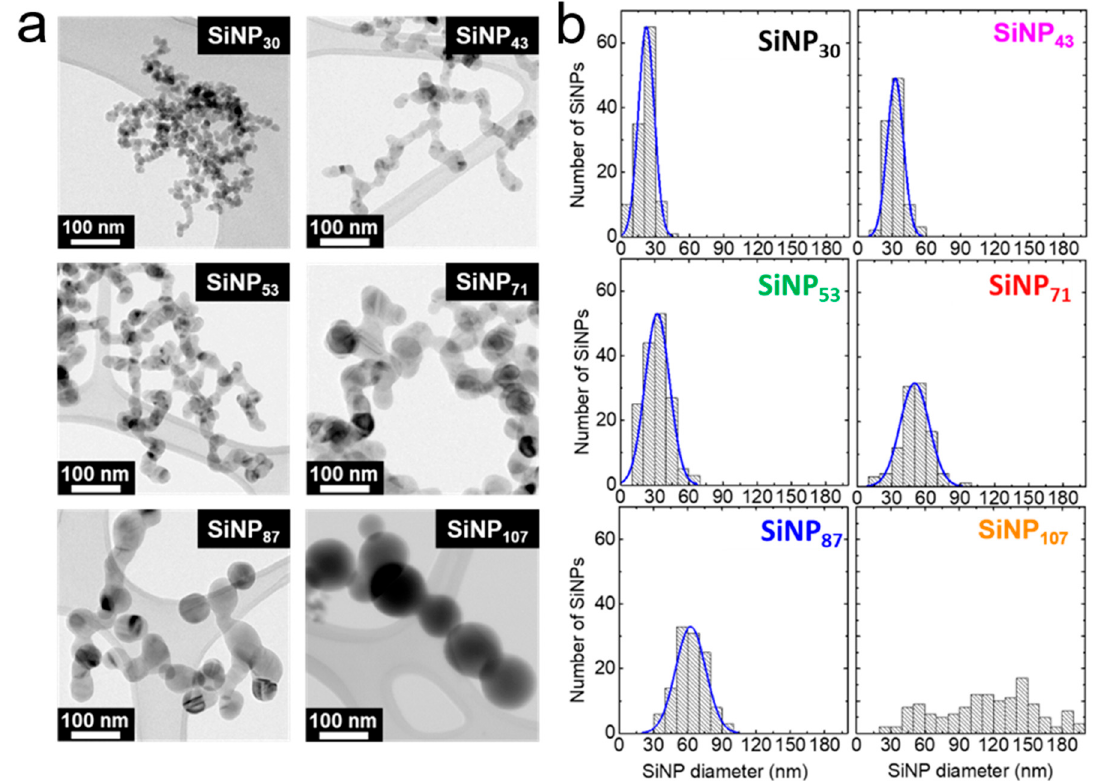
Figure 1. TEM images ( a ) and corresponding size analysis ( b ) of the SiNPs samples described in Table 1. The histograms were obtained from at least 100 particle measurements.